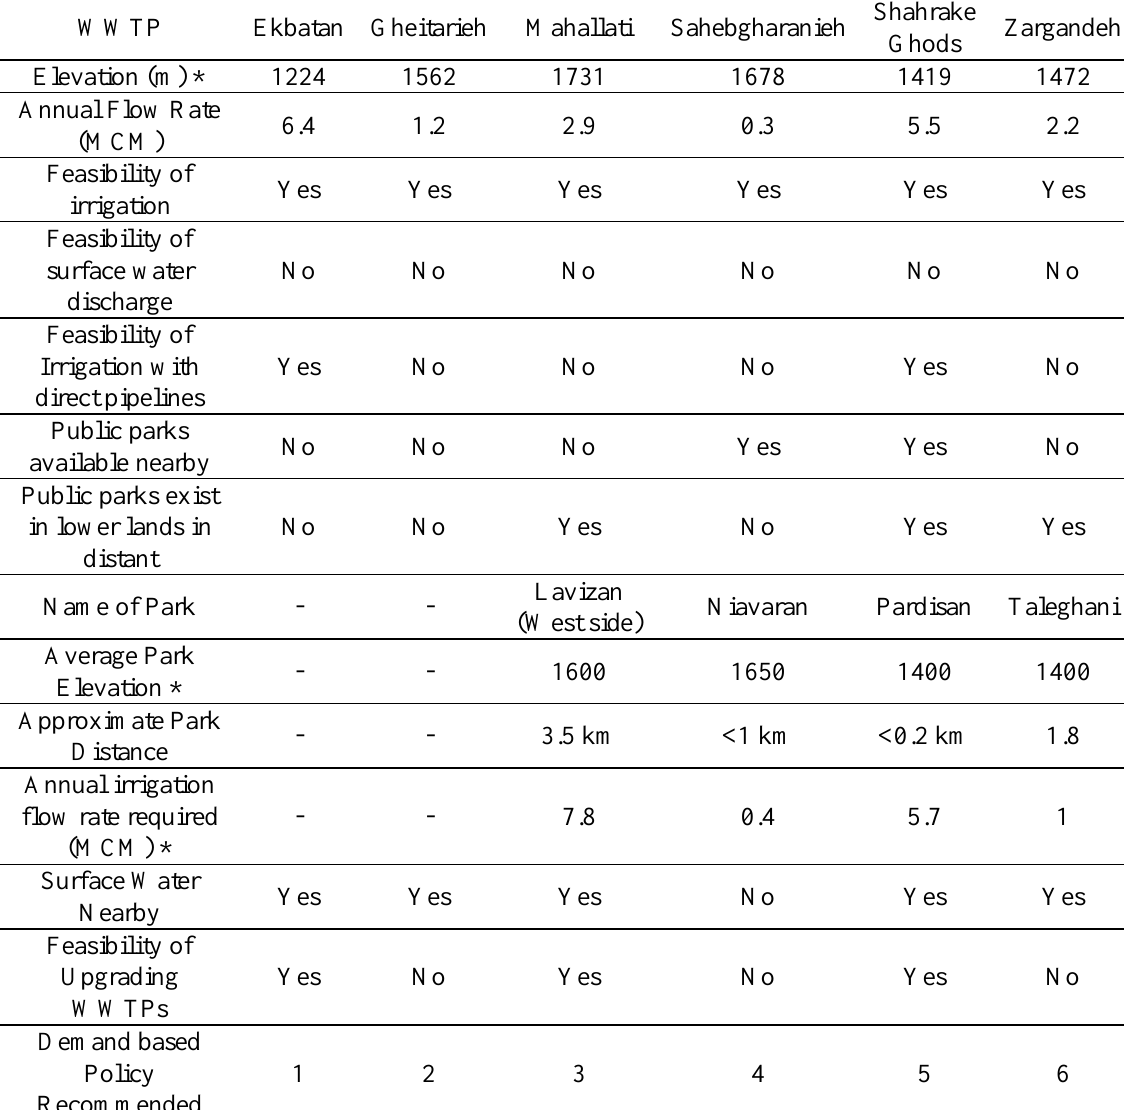
Table 2. Overall specifications of wastewater treatment plants with feasible reuse applications and policy